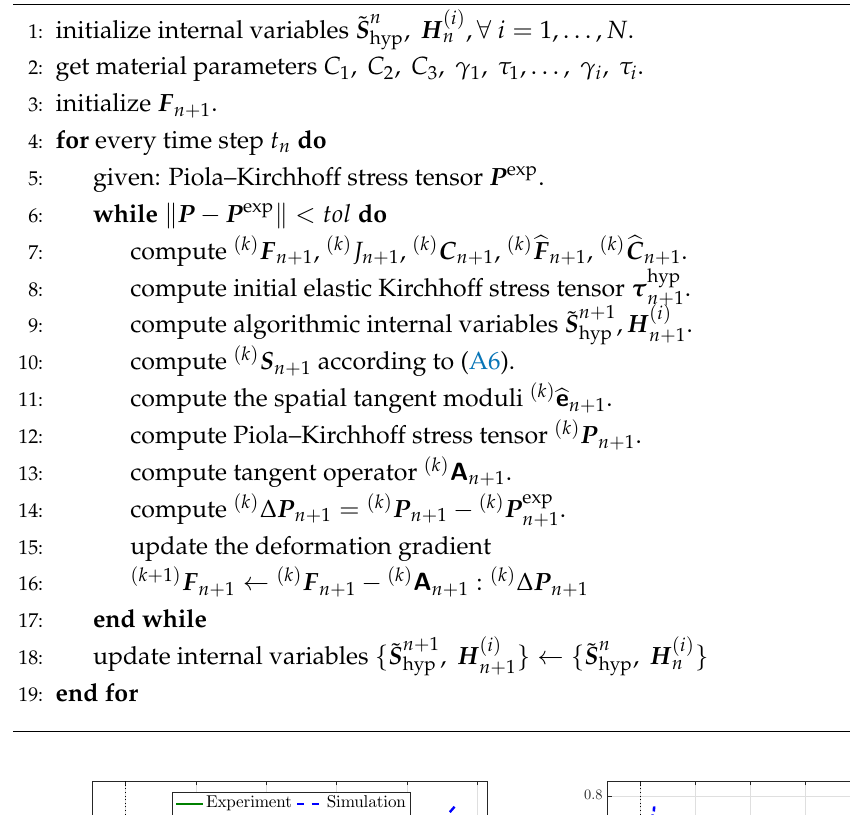
Algorithm 2 Stress-driven constitutive driver (creep)—uni-axial stress state; see also Appendix A.